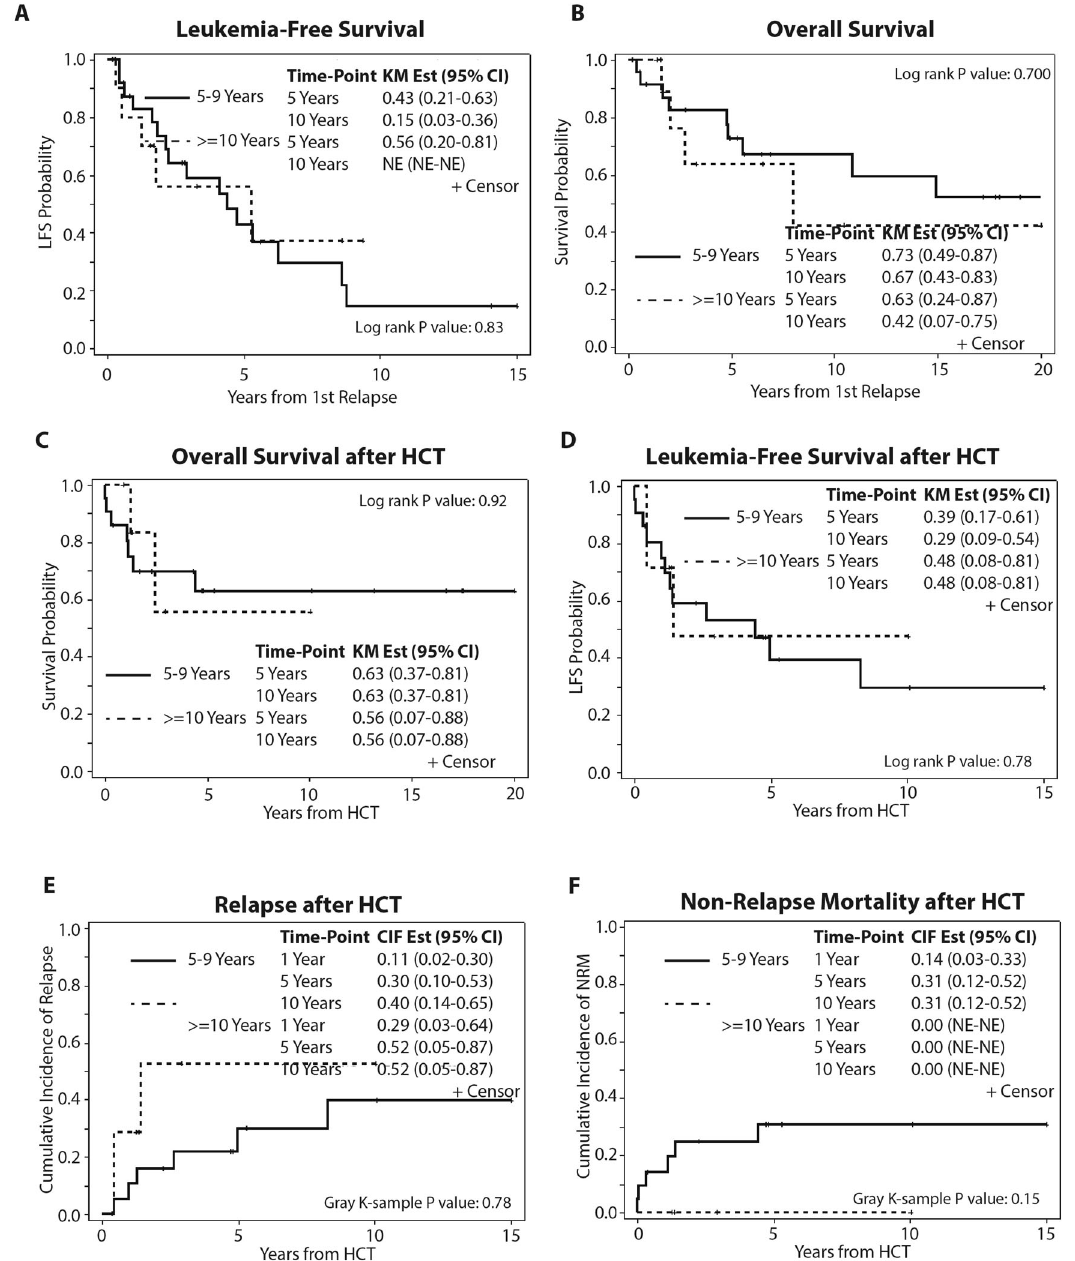
Fig. 1 Outcomes of late and very late relapse outcomes. A Leukemia-free survival after late relapse. B Overall survival after late relapse. C Overall survival after HCT. D Leukemia-free survival after HCT, E Relapse after HCT, and D Non-relapse mortality after HCT. Overall survival and leukemia-free survival were compared using Kaplan – Meier curves and log-rank tests. Non-relapse mortality and time to relapse were assessed using cumulative incidence